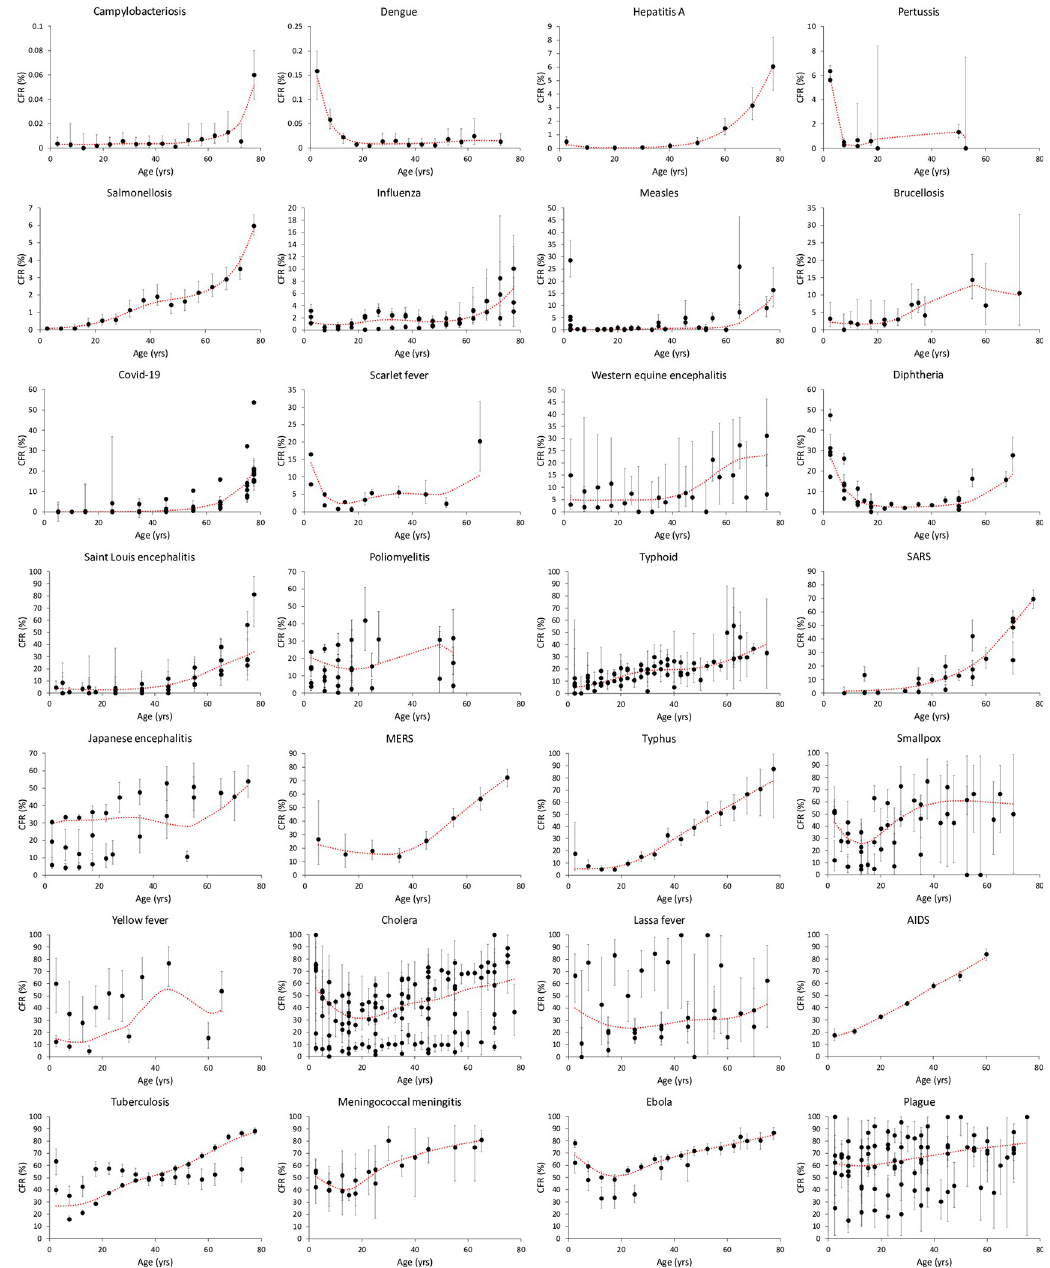
Fig 1. Age-dependent variation of CFR (%) for the 28 human infectious diseases considered in the study. Each dot represents the percent of infected people dying (number of deaths/number of cases) in each age class. Bars represent the binomial 95% confidence intervals. The dotted lines represent the fit of the GAMs. Multiple CFR values for a given age class refer to independent datasets. Model 1 included the incubation period, the duration of symptoms/illness and whether the pathogen produces a local or a systemic infection. Among the 19 competing models, the one with the lowest BIC value included the interaction between age and duration of symptoms/ill- ness (Tables 2 and S2), and showed that CFR increased more with age for diseases producing long-lasting symptoms (Fig 2).